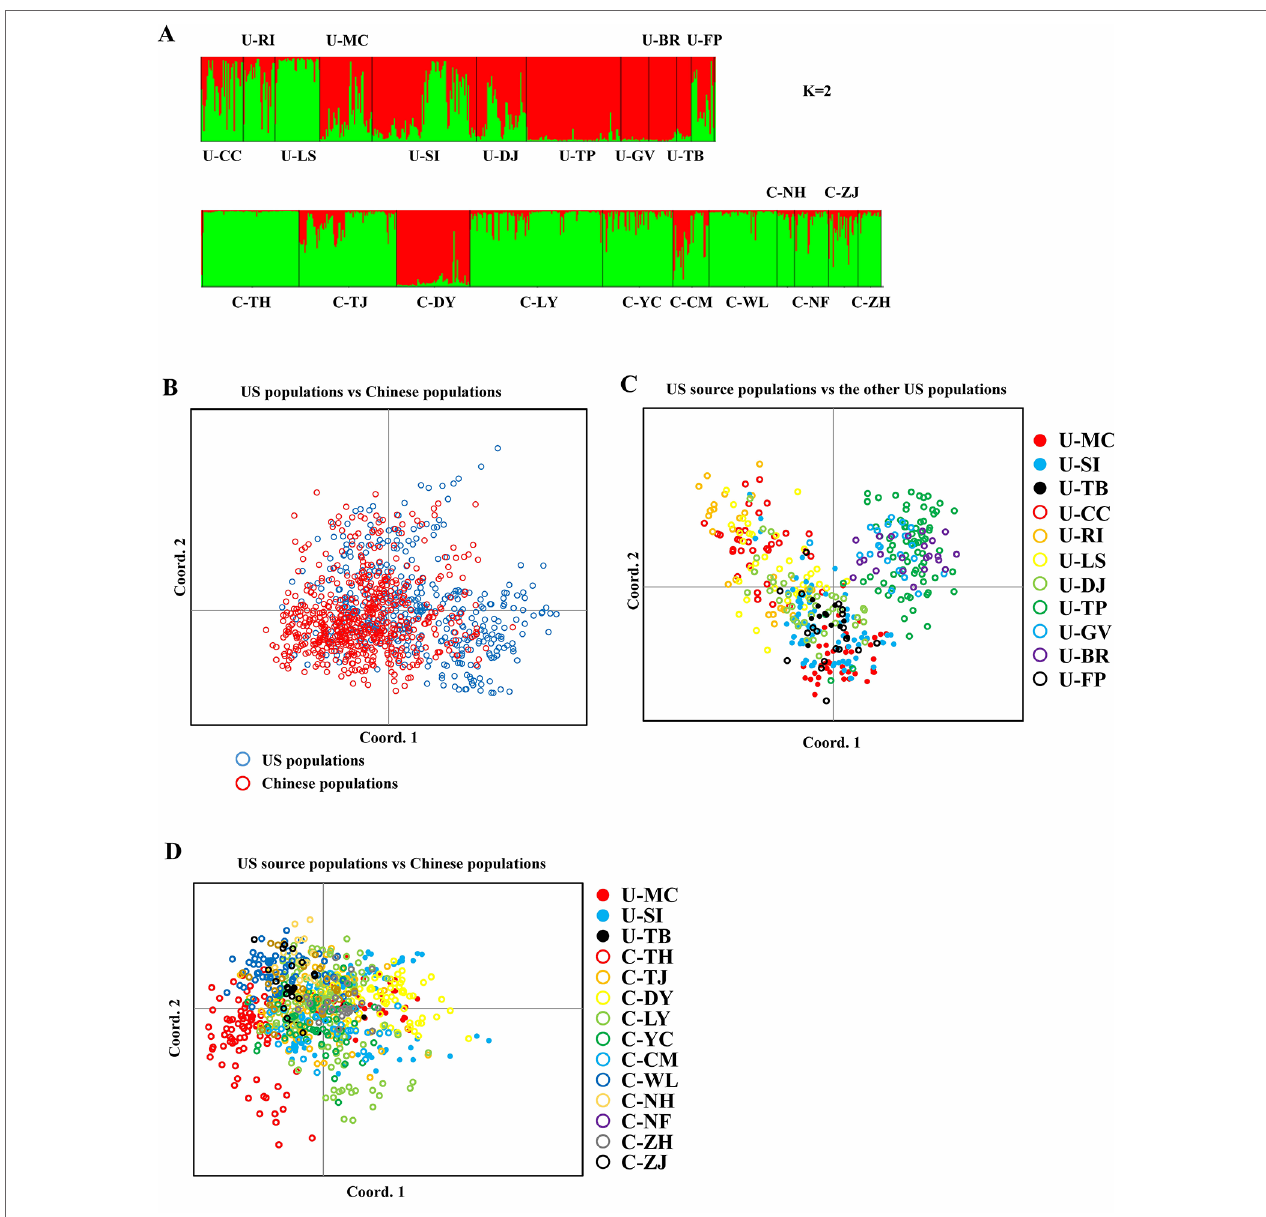
FIGUre 1 | Genetic assignments and principal coordinate analyses (PCoA) of the native United States (US) and invasive Chinese Spartina alterniflora populations. (a) Bar plot estimated by STRUCTURE representing assignments of genotypes of S. alterniflora from all populations to each cluster (K = 2). (B) PCoA of S. alterniflora between US and Chinese populations. (C) PCoA of S. alterniflora between US source populations and the other US populations. (D) PCoA of S. alterniflora between US source populations and Chinese